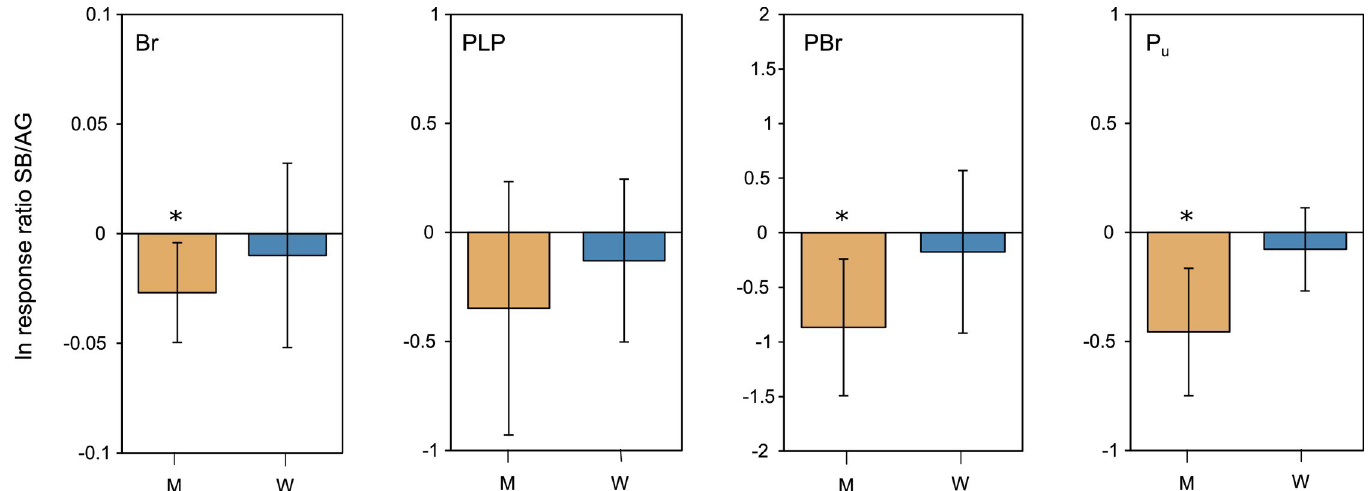
Fig 2. Mean ( ± 95% CI) ln response ratio of Br , PLP , PBr , and P between seed bank and aboveground cohorts in meadow (M) and in woodland (W) habitats, u respectively. Br —band richness, PLP —percentage of polymorphic loci at the 5% level; PBr —pairwise private band richness (aboveground vs. seed bank); P u —proportion of unique AFLP-phenotypes. Negative ln response ratios denote higher values in the aboveground cohort. Differences between aboveground and seed bank cohorts were considered significant when 95% CI did not overlap with zero.